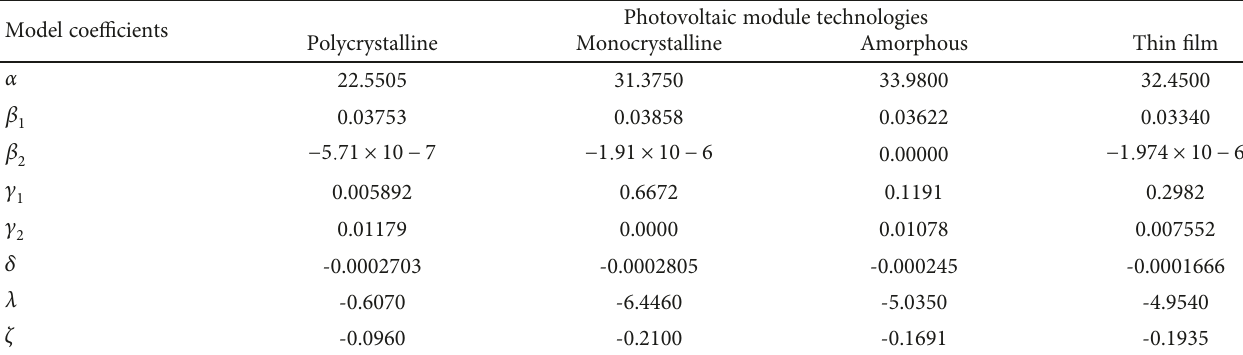
Table 4: Proposed model coe ffi